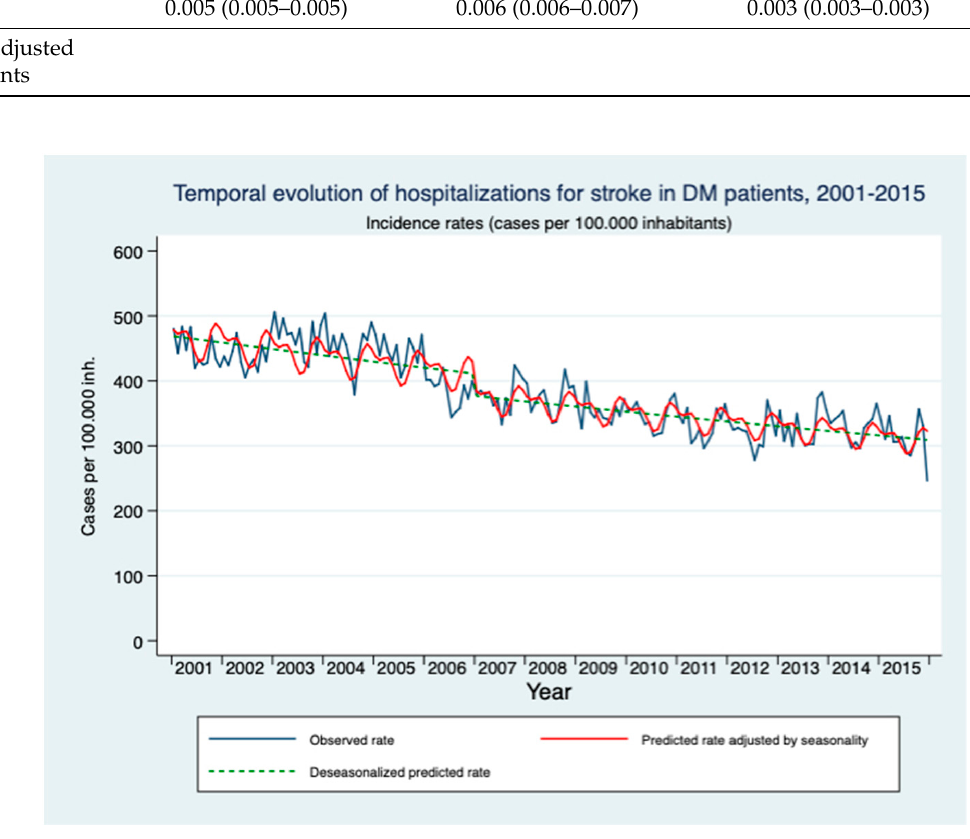
Figure 1. Modeling of the temporal evolution of the stroke hospitalization rate in people over